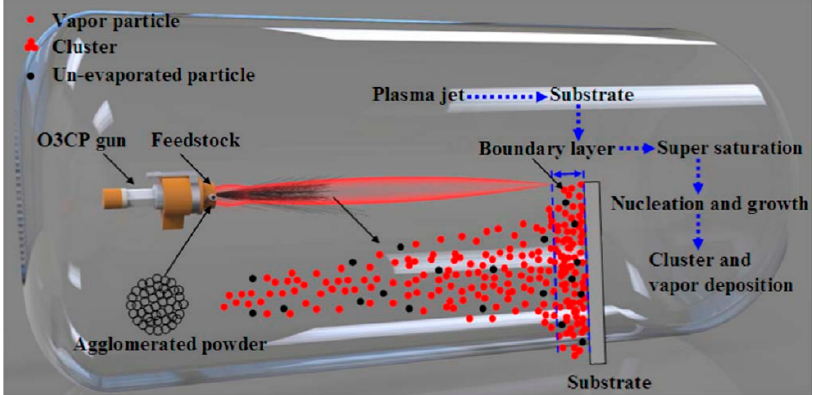
Figure 4. Scheme of PS-PVD working principle and equipment [43].